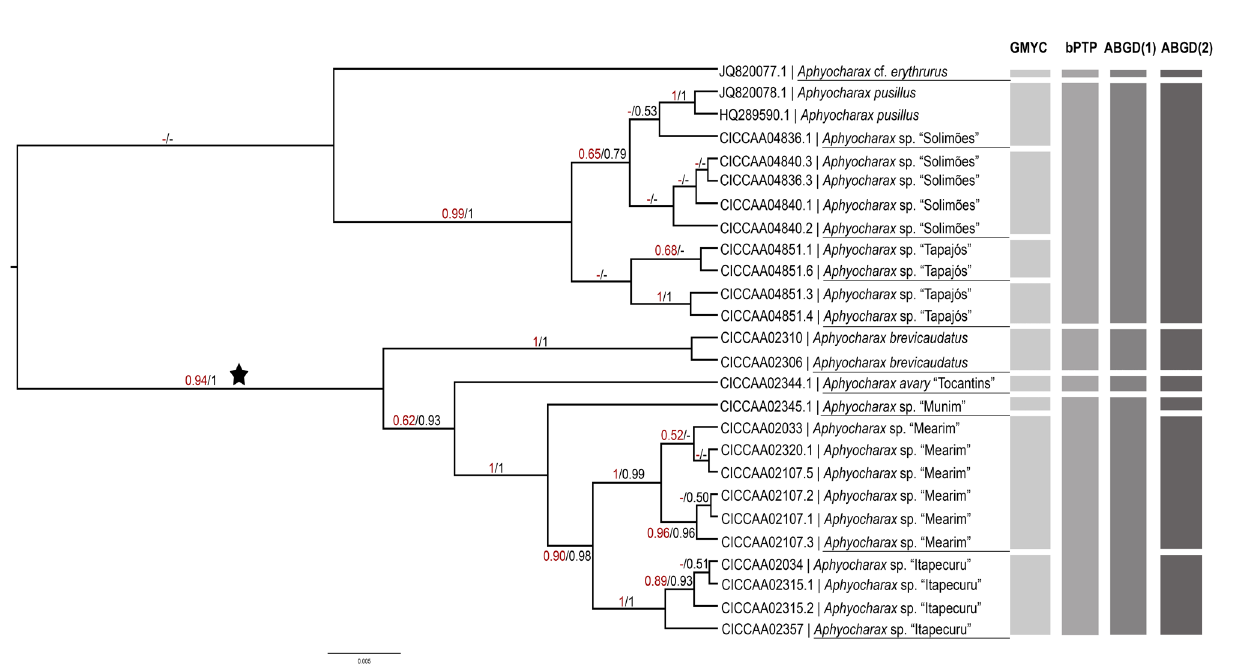
FIGURE 3 | Ultrametric tree (Bayesian inference) including unique haplotypes summarizing the results of the GMYC, bPTP and ABGD (results 1 and 2). Numbers above and below branches are posterior probability values. Red values: posterior probabilities calculated by the software Beast; black values: posterior probabilities calculated by the software Mr. Bayes. Values below 50 are indicated as “- “. The stars indicate the